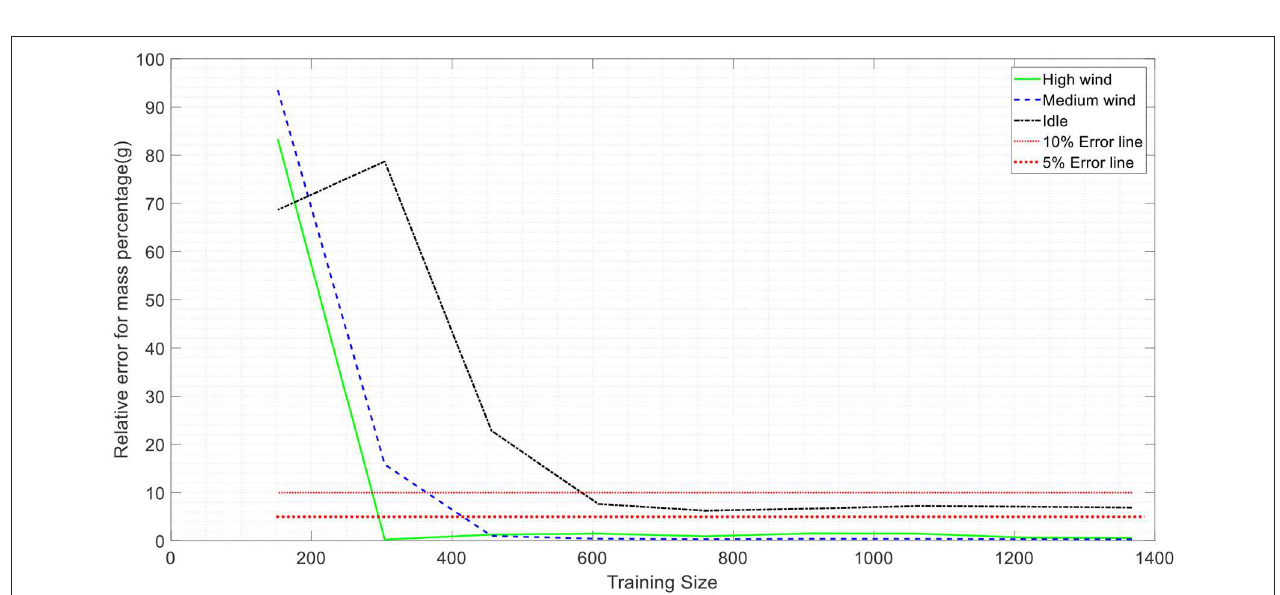
FIGURE 8 | Variation predication of standard deviation values for firebrand mass with sample